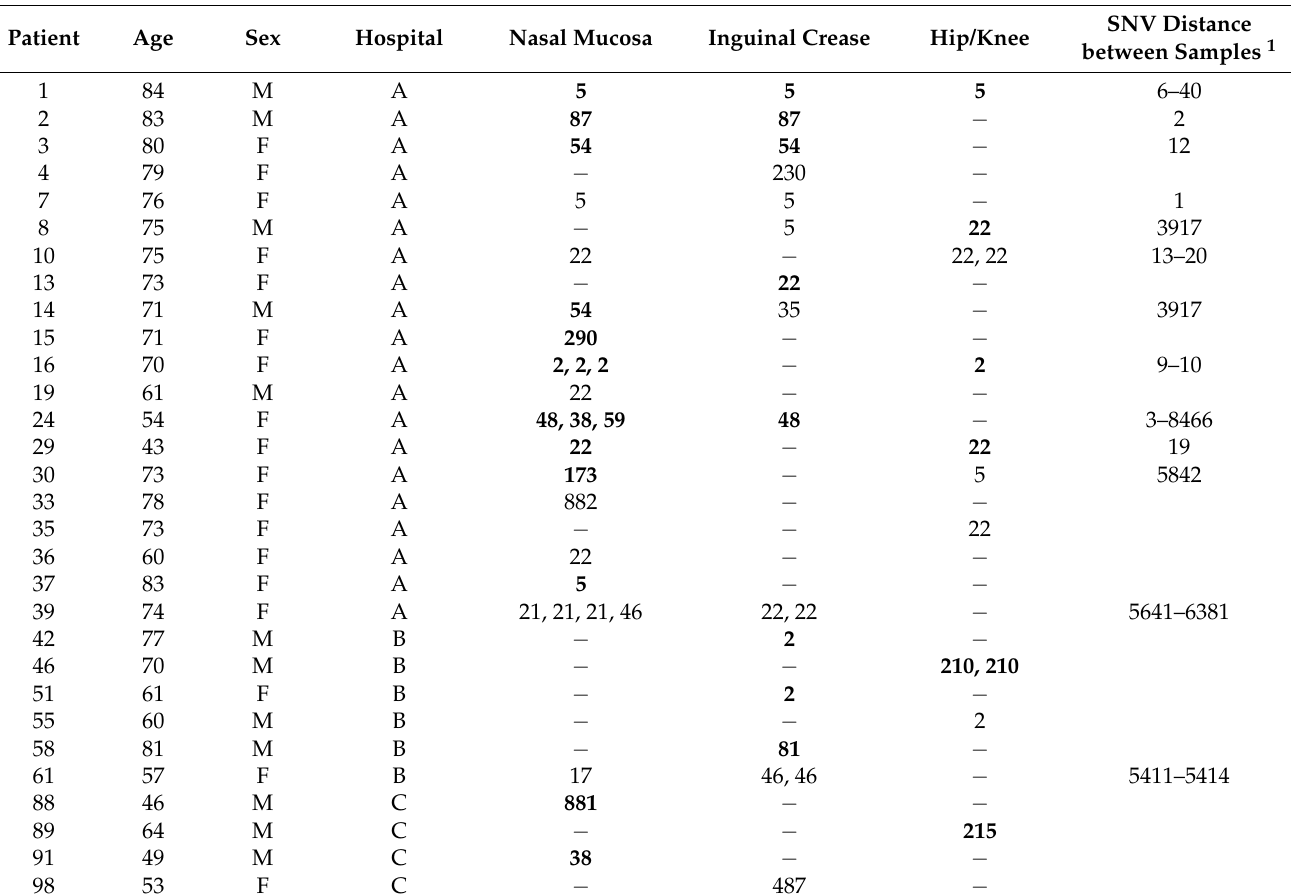
patient, MRSE was retrieved in all three samples (Table 1). Table 1. Sequence-types (STs) of methicillin-resistant S. epidermidis (MRSE) per patient and sample (nasal/inguinal crease/skin over hip/knee): number in bold indicates multidrug-resistant MRSE. Intra-patient single nucleotide variant (SNV) distances between samples (far right) highlight that MRSE with identical STs differ by 1–40 SNVs between two samples from the same